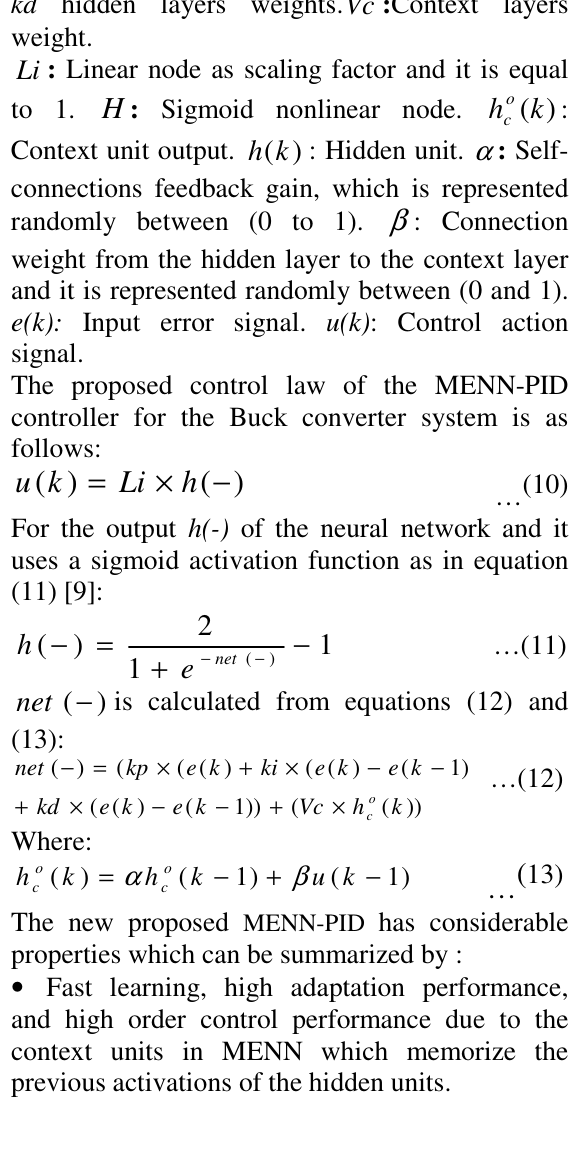
The network weights notation are: kp, ki, and kd hidden layers weights. Vc : Context layers